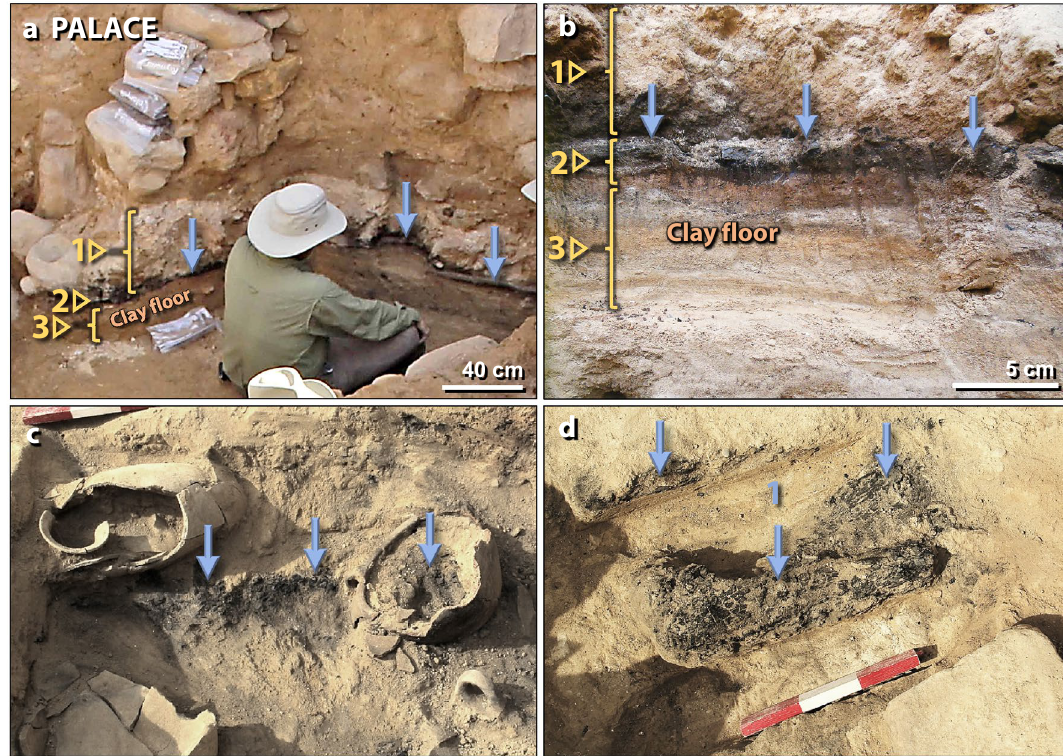
Figure 7. Destruction layer in the palace. ( a ) Photo of excavation in an exterior food preparation area of the palace. #1 marks MB II debris that was most likely deposited by post-fire erosion. #2 points to charcoal-rich ‘dark layer’ indicating a major fire in the palace. Contains fragments of plaster and limestone spherules. Blue arrows mark its top. #3 points to the cross-section of excavated clay flooring. ( b ) Close-up photo of the same palace sampling sequence as in panel ‘ a ’. ( c ) Photo of broken pots with carbonized grains embedded in MB II 1.5-m-thick debris matrix, mostly composed of pulverized mudbrick and plaster fragments and limestone spherules. Debris matrix is found in the space between all palace walls. Note charcoal inside the broken pot. The end of a scale stick with 10-cm divisions is at upper left. ( d ) Charred palace roof timber surrounded